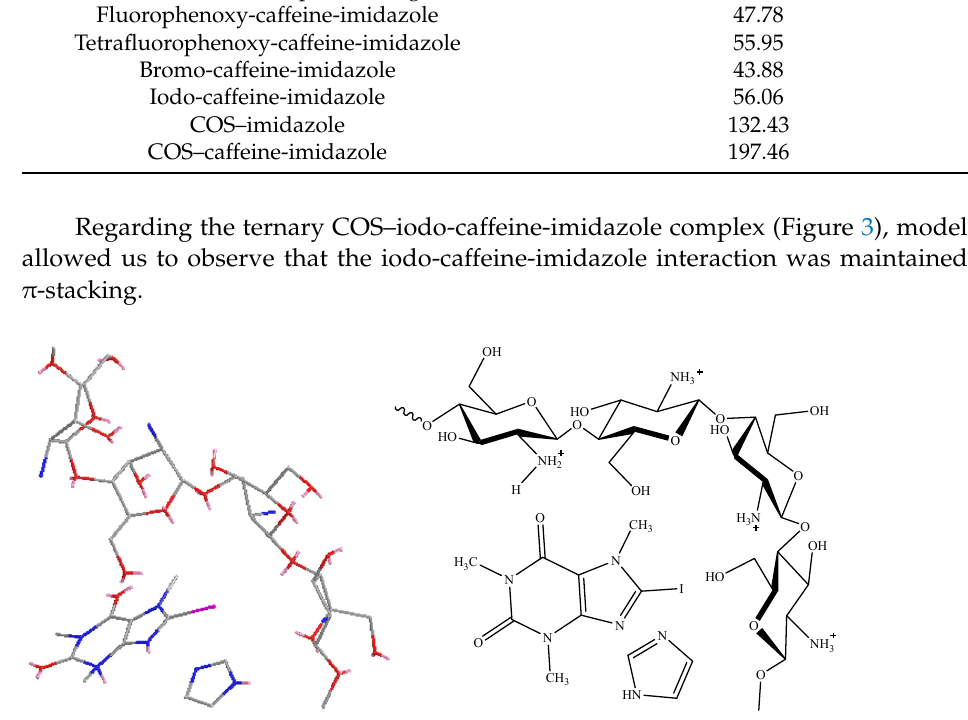
Figure 3. Structural modeling of the COS–iodo-caffeine-imidazole complex.